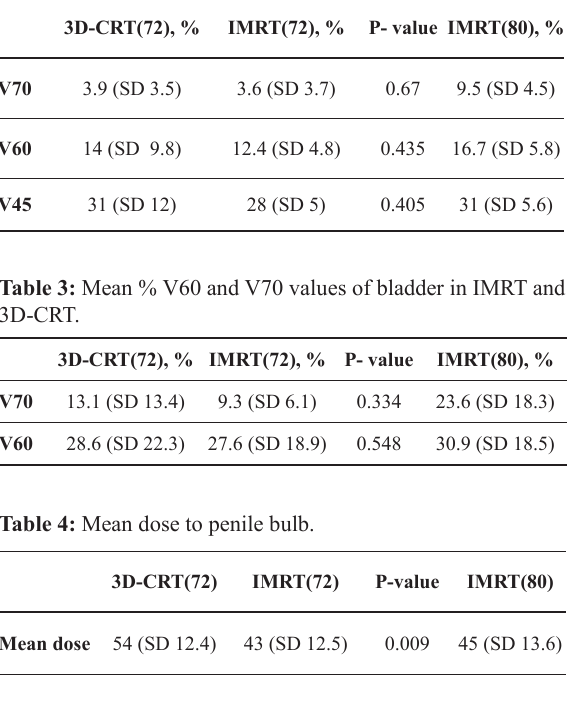
Table 2: Mean % V45, V60 and V70 values of rectum in IMRT and 3D-CRT.